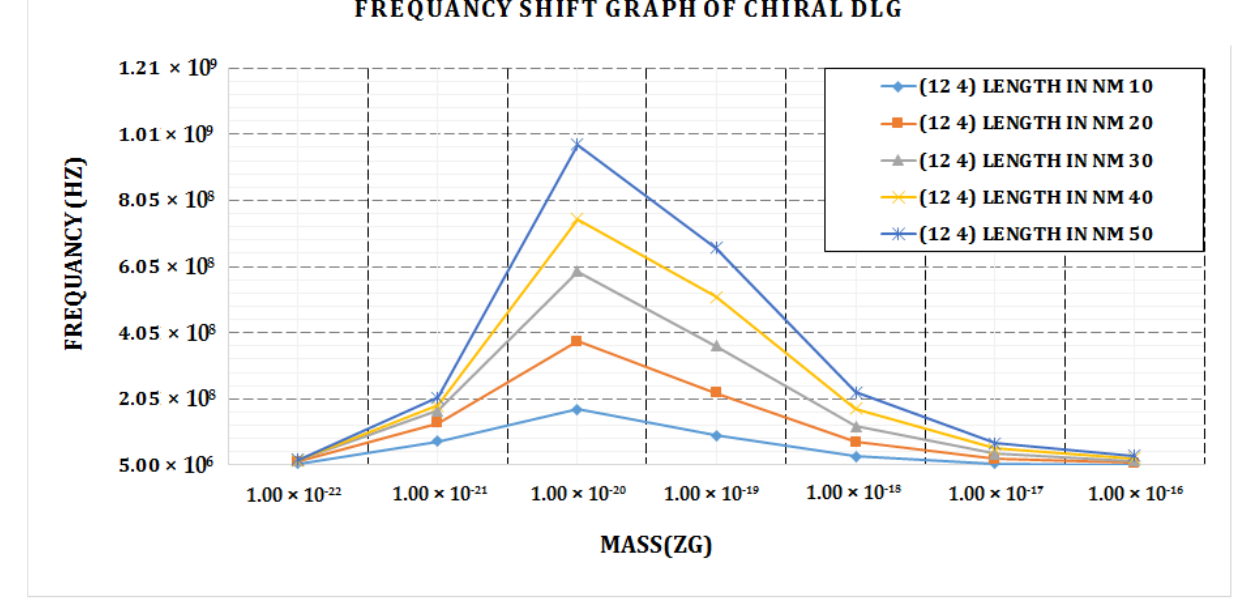
Figure 7. Frequency shift vs. attached mass graph of bridged chiral DLG (12, 4).